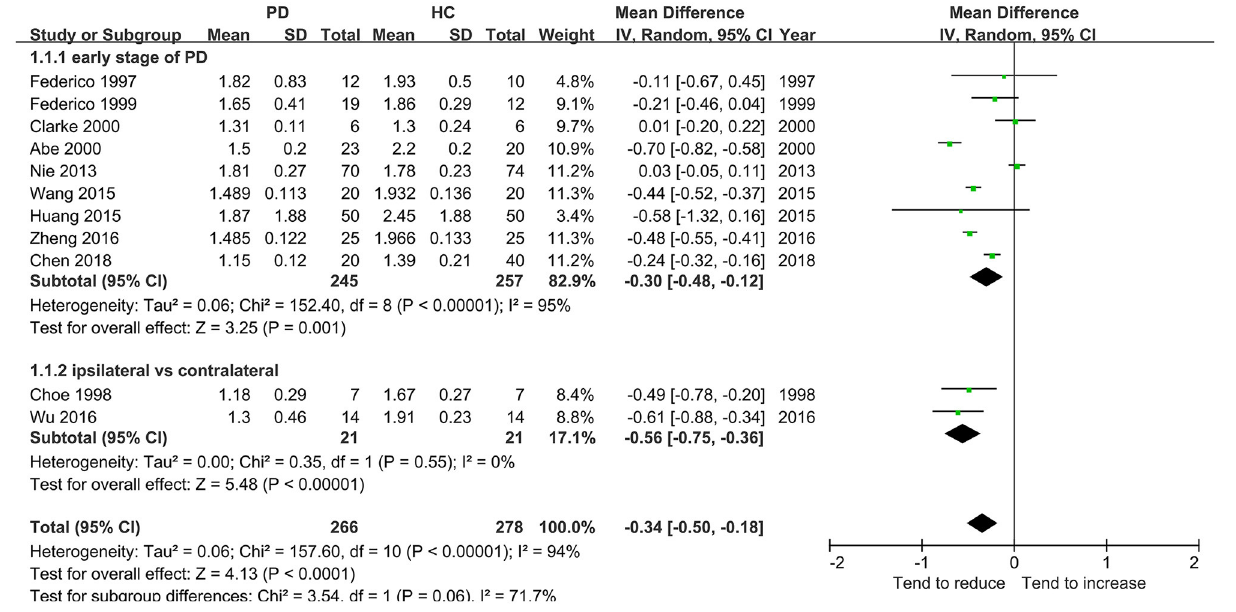
FIGURE 2 | Forest plot of the NAA-to-Cr ratio in GP in patients with early-stage PD vs. HC.